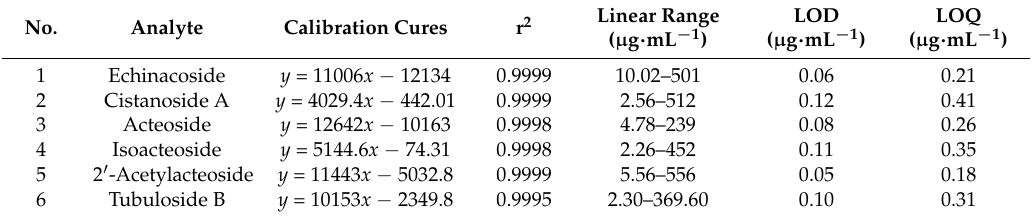
Table 2. Calibration curves, linear range, LOD and LOQ for the six PhGs by UPLC-PDA.